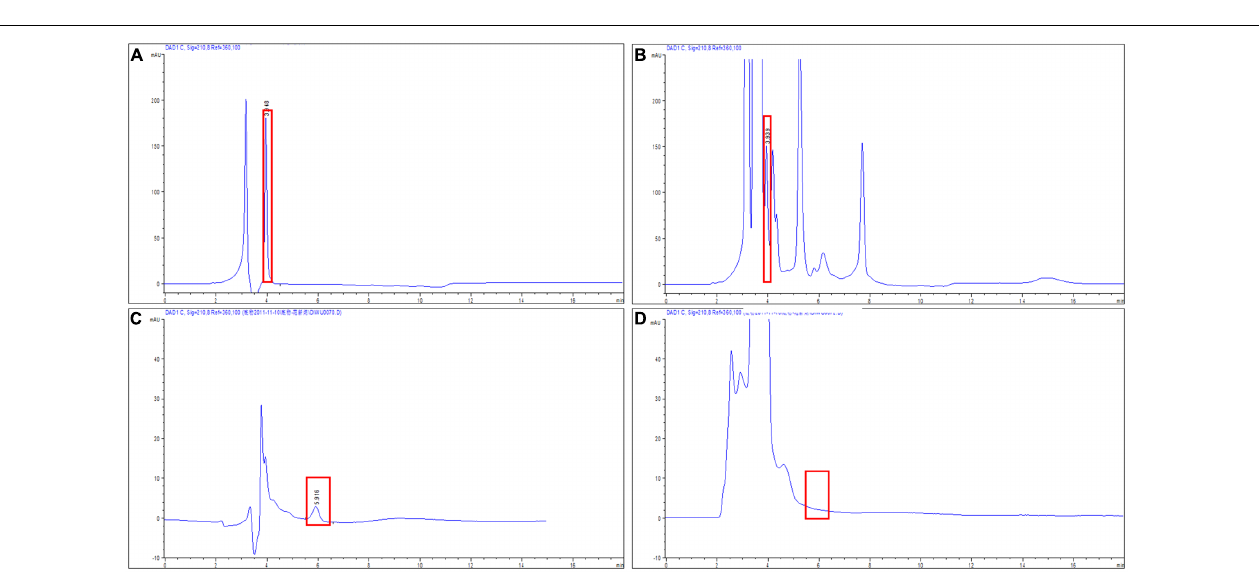
), and 45 ◦ C ( ) for different intervals. Effect of pH on activity ( (cid:4) ) and (cid:32) (cid:35)